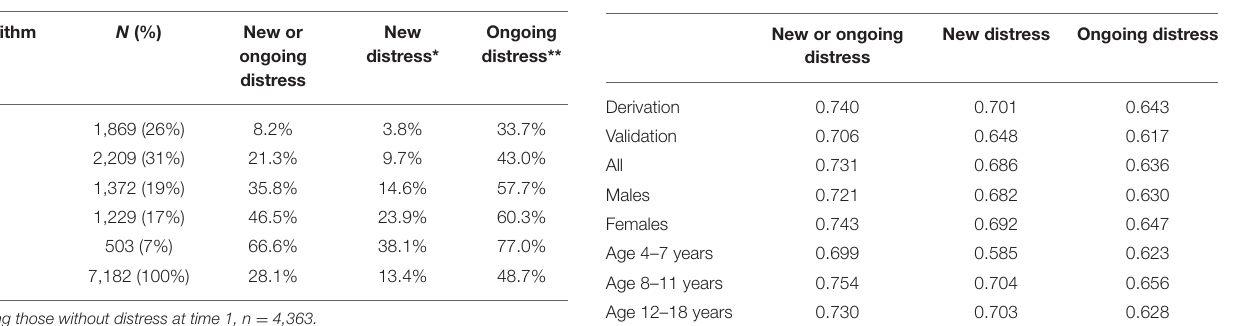
TABLE 2 | ChYMH Caregiver Distress Algorithm results. TABLE 3 | ChYMH Caregiver Distress Algorithm goodness of Fit C-statistics *